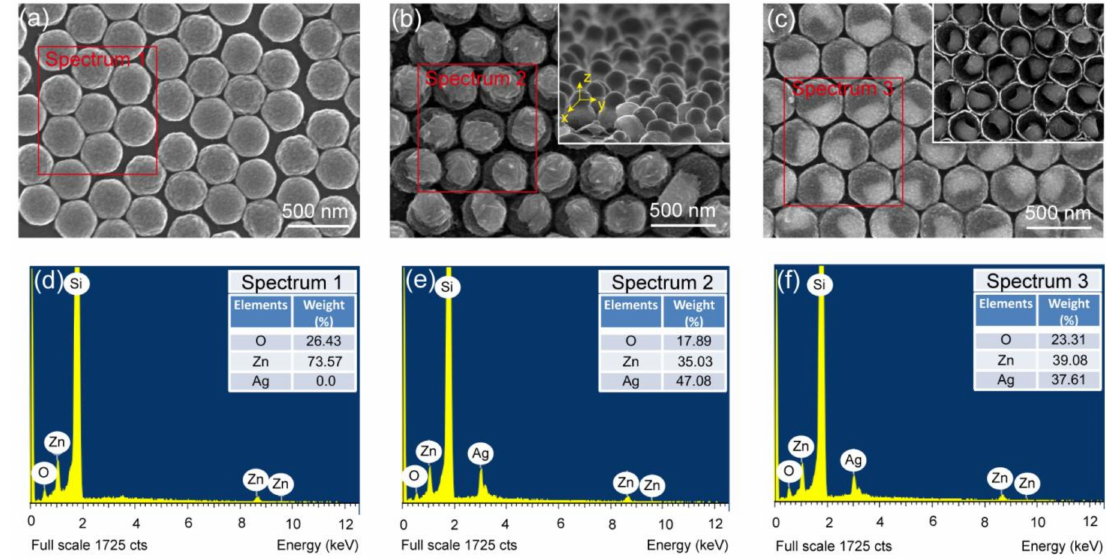
Figure 3. Top-view SEM images of ( a ) ZCA, ( b ) SZCA, and ( c ) ZSCA. The corresponding EDS spectra of ( d ) ZCA, ( e ) SZCA, and ( f ) ZSCA are also presented. The inset in ( b ) shows the side-view morphology of SZCA and the Cartesian coordinate system mentioned in the computational method. The inset in ( c ) refers to the inverted top-view morphology of ZSCA, indicating the trapping of AgNPs into ZnO nanocavities. The EDS spectra are collected from the regions marked with red boxes in ( a – c ), and the insets in ( d – f ) show the element weights determined from the corresponding EDS spectra. Note that in order to observe the interior structures of ZSCA, arrays on the Si substrate were lifted off by conductive tape and then inverted ZSCA were